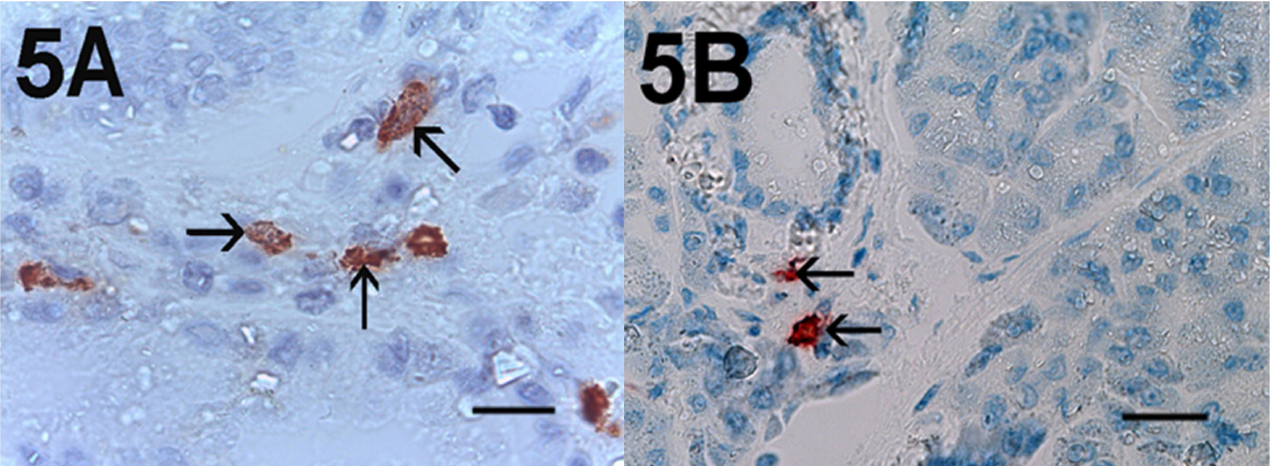
Figure 5. Magnification × 1000 in oil, 0.06 mm 2 area, immunostaining with the anti-tryptase antibody. ( A ) High MCDPT in primary PDAT section. Small arrows indicate single red-immunostained MCs. Magnification × 1000 in oil. ( B ) Low MCDPT in ANT section. Small arrows indicate red-stained MCs. Scale bar corresponds to 150 µ